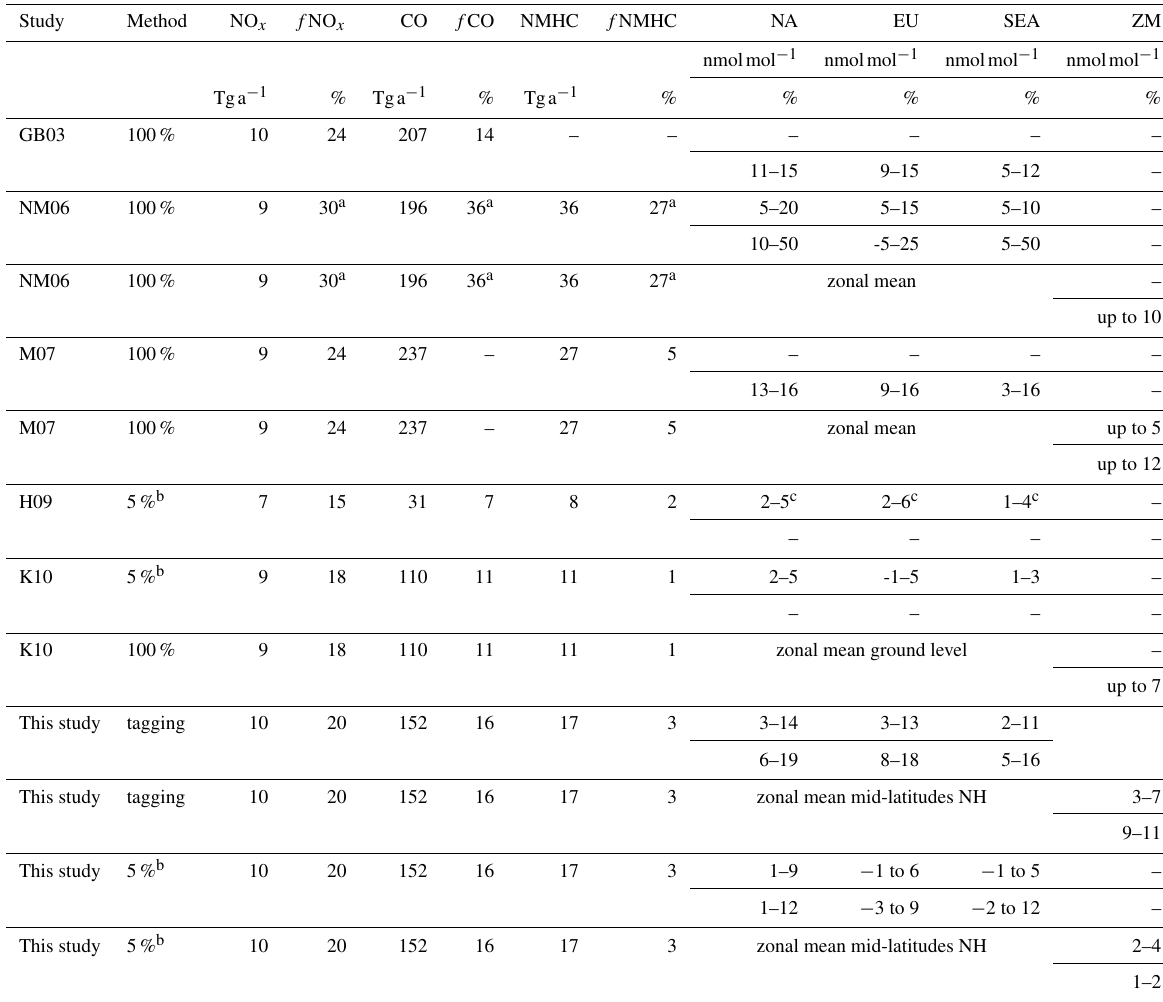
Table 3. Summary of previous global model studies investigating the contribution and impact of land transport and road traffic emissions to ozone. Method denotes the percentage of the emissions reductions (perturbation). The other columns list the amount of land transport and road traffic emissions as well as the fraction ( f ) compared to the emissions used in the studies for NO x (in Tg ( N ) a − 1 ), CO (in Tg ( CO ) a − 1 ), and NMHC (Tg ( C ) a − 1 ). The four rows on the right list the contribution of the land transport and road traffic categories as estimated by these studies in mixing ratios and/or percent. Where possible, we show the estimated contribution for the geographical regions defined in Sect. 2 and zonal average values (ZM). All contributions are given to near-ground-level ozone and for July conditions. The table is ordered by the year of publication. A “–” indicates missing